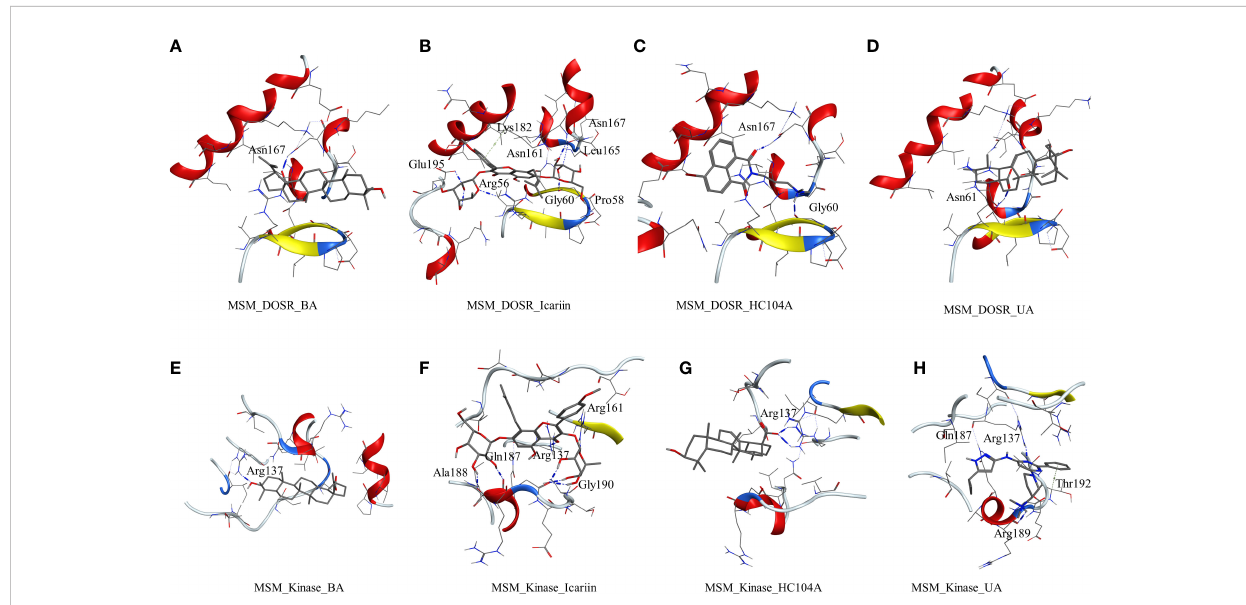
FIGURE 2 Molecular docking results for M. smegmatis dormancy survival regulator (DosR): (A) DosR – betulinic acid (BA), (B) DosR – icariin (IC), (C) DosR – HC104A, and (D) DosR – UA. Molecular docking results for M. smegmatis serine/threonine-protein kinase (STPK): (E) STPK – BA, (F) STPK – IC, (G) STPK – UA, and (H) STPK –